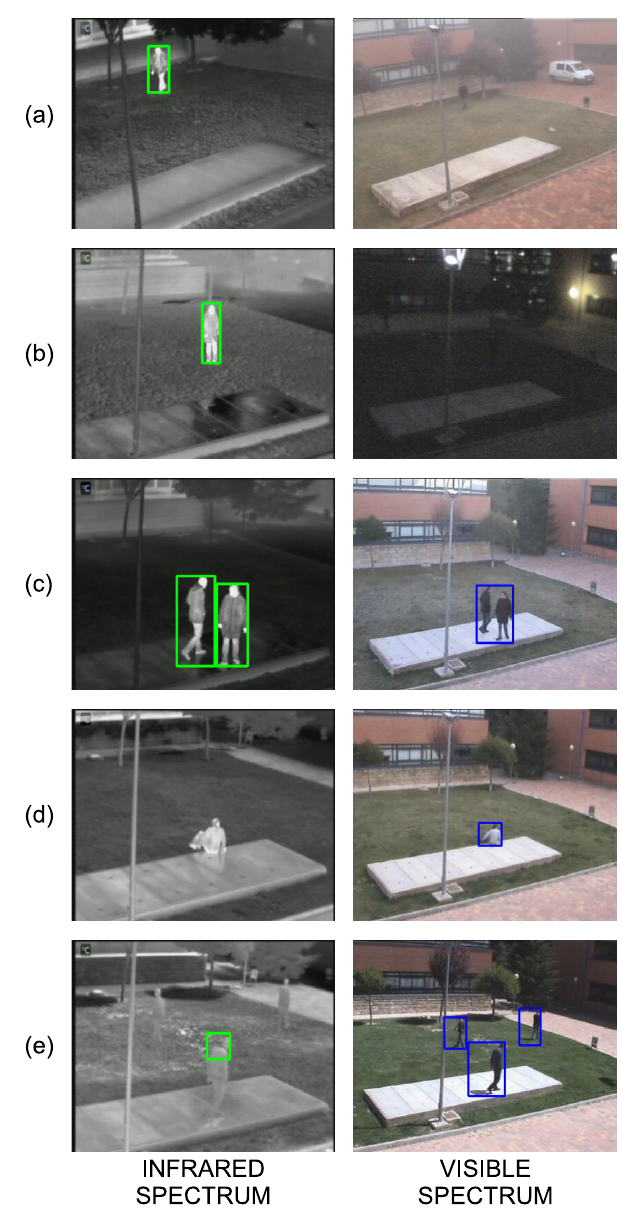
Figure 7. Results obtained on both spectra for the analyzed